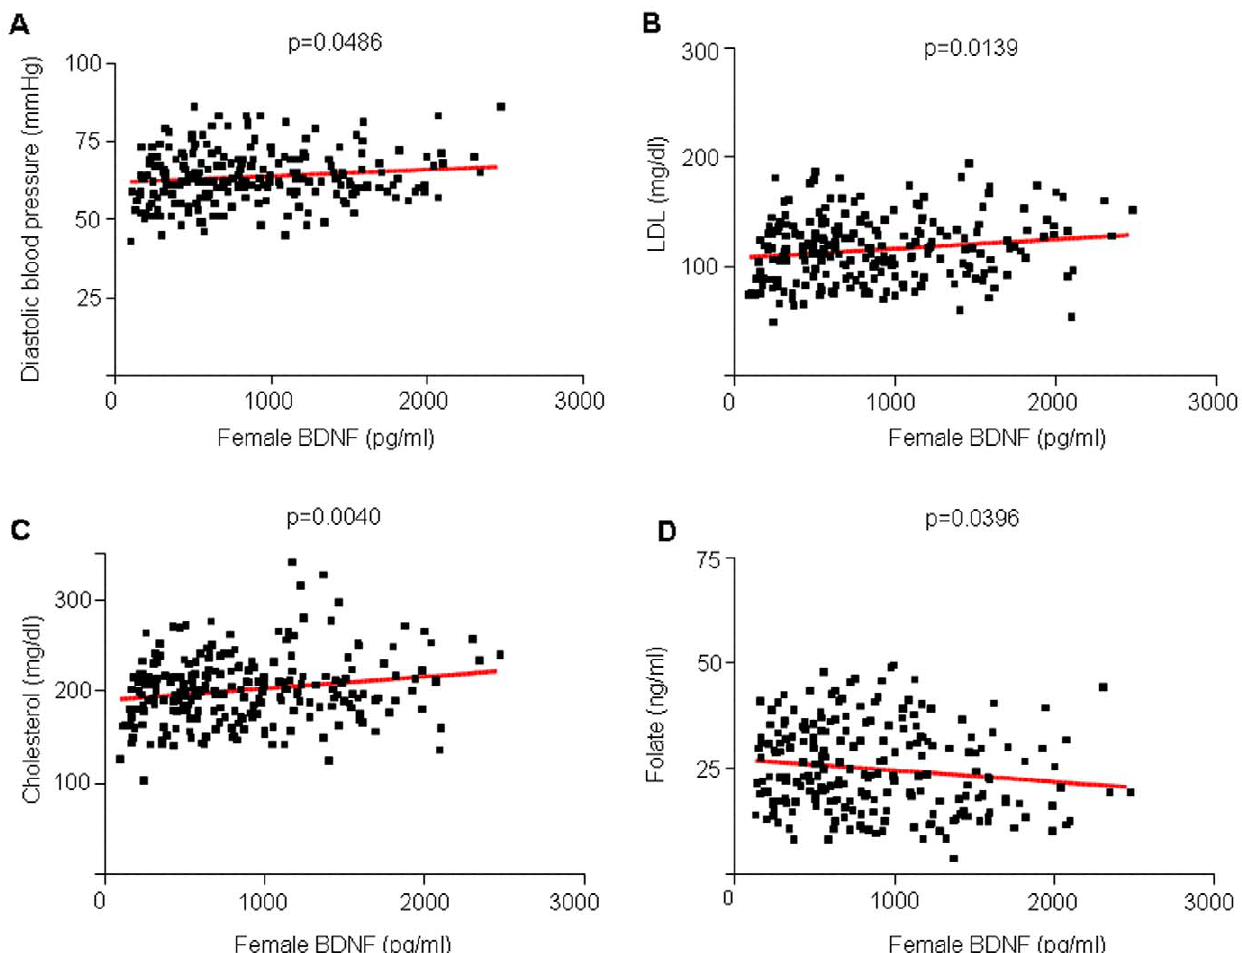
Figure 2. Linear regression analysis correlating plasma BDNF and markers of cardiovascular risk in females. A, B and C. Plasma BDNF was positively correlated with diastolic blood pressure (p , 0.05, R 2 =0.0228), LDL-cholesterol (p=0.139, R 2 =0.02634), and total cholesterol (p=0.0040, R 2 =0.03487). D. Folate levels were inversely correlated with plasma BDNF (p=0.0396, R 2 =0.01885).